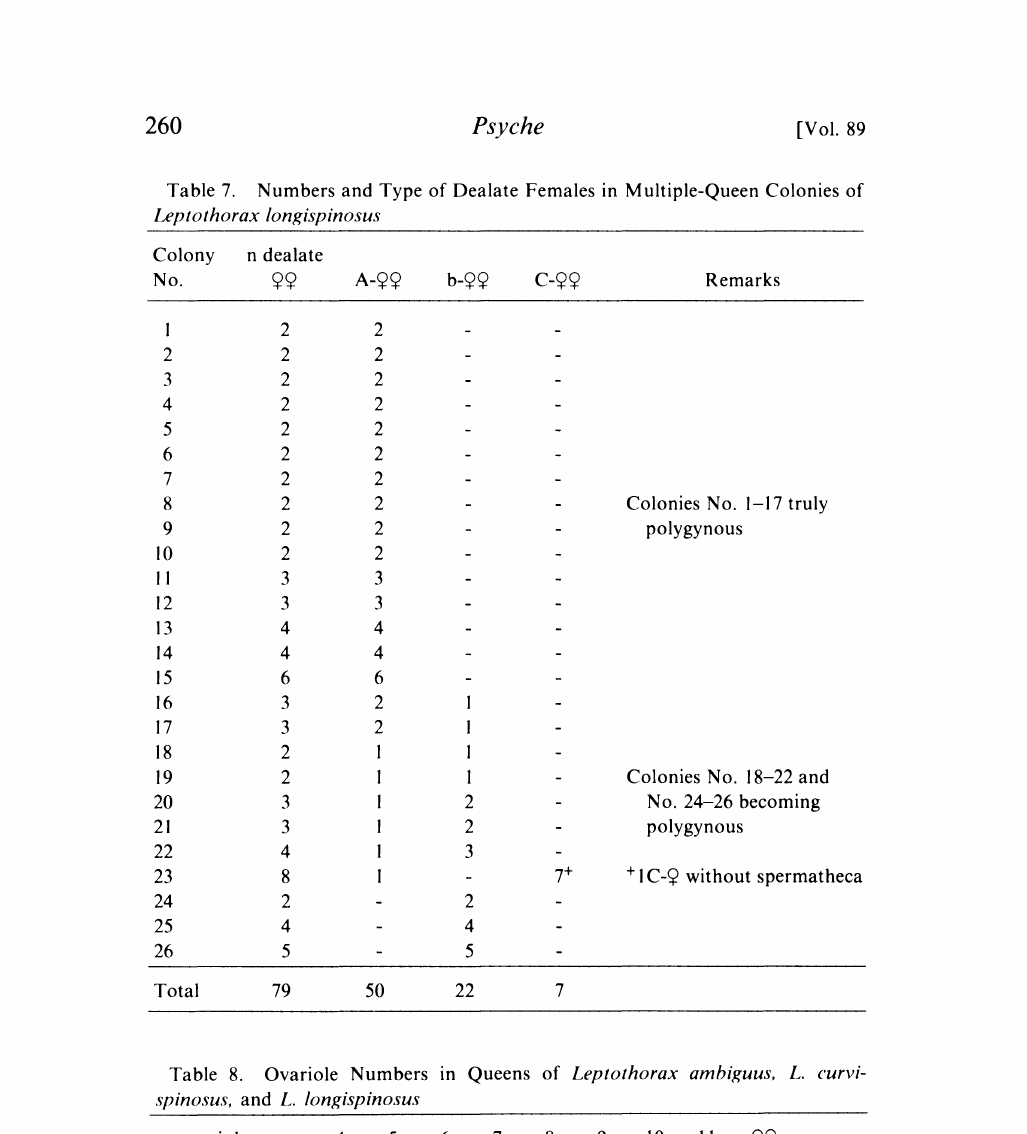
Table 8. Ovariole Numbers in Queens of Leptothorax ambiguus, L. curvi- spinosus, and L.